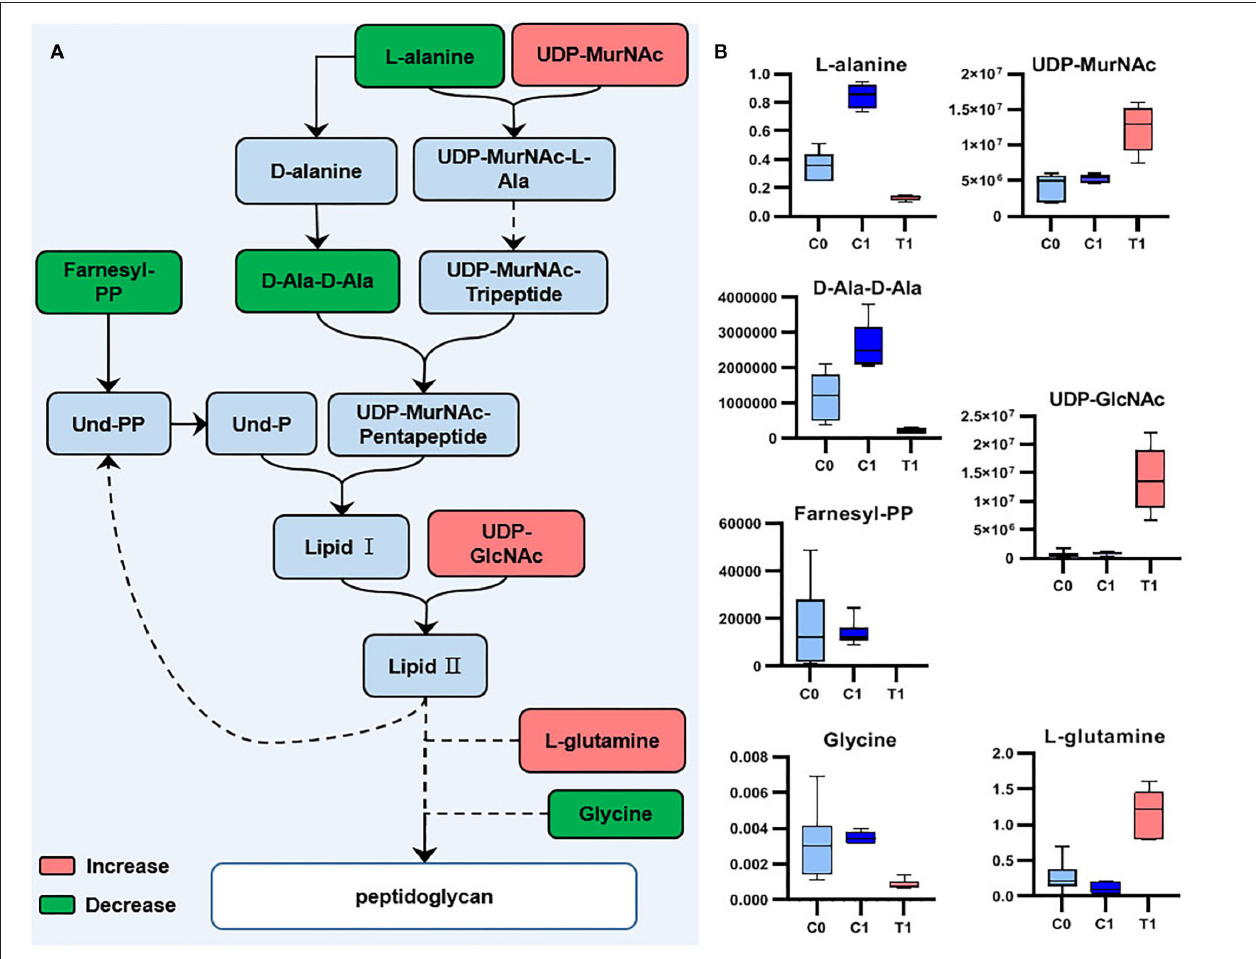
FIGURE 4 | Significant metabolites involved in peptidoglycan biosynthesis. (A) Relationship among metabolites. (B) Box plots for significant metabolites (|log 2 FC| > 1; P < 0.05; adj. P -value <